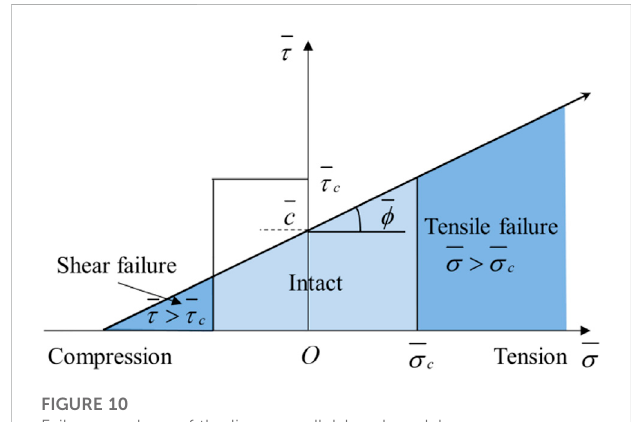
FIGURE 10 Failure envelope of the linear parallel-bond